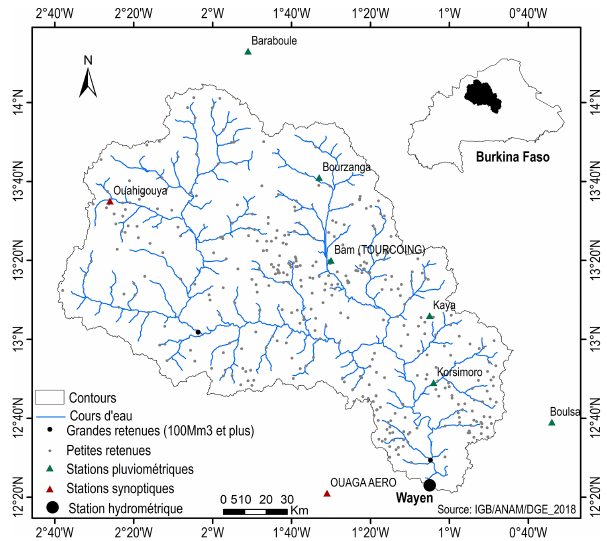
Figure 1. Zone d’étude : Bassin du Nakanbé à